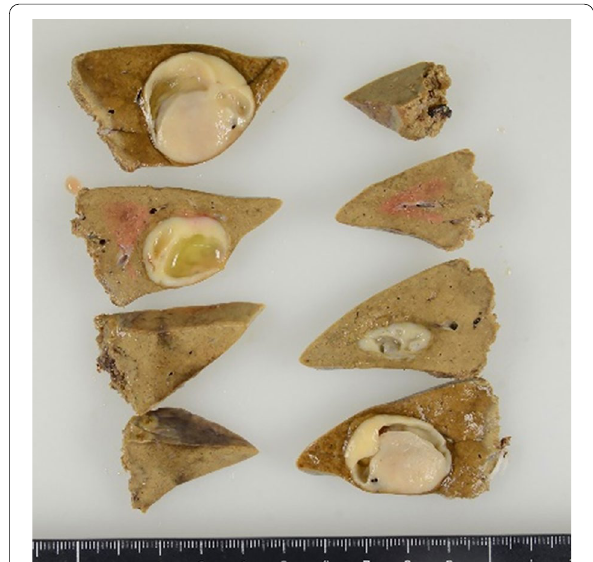
Fig. 2 Macroscopic of the resected specimen. The surgical specimen contained a nodular, yellow–white mass lesion with clear borders 20 mm in size. The cut plane was smooth and glossy with a slight